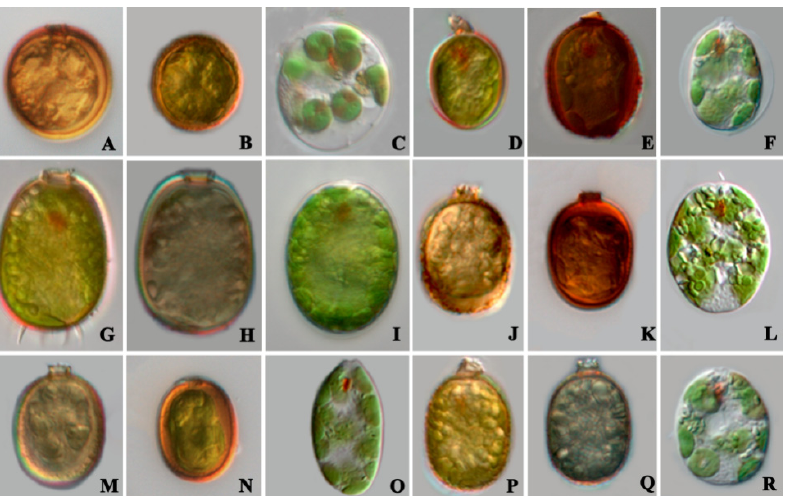
Figure 1. Morphology of Trachelomonas strains in this study. Each species includes: morphology of lorica in the field (left), morphology of lorica in culture (middle), Protoplast morphology (right). ( A – C ) T. cervicula strain SHNUS39D1; ( D – F ) T. playfairii strain SHNUN14B1; ( G – I ) T. armata strain SHNUS50B3; ( J – L ) T. lefevrei strain SHNUCC; ( M – O ) T. planctonica var. o blonga strain SHNUS2C1;